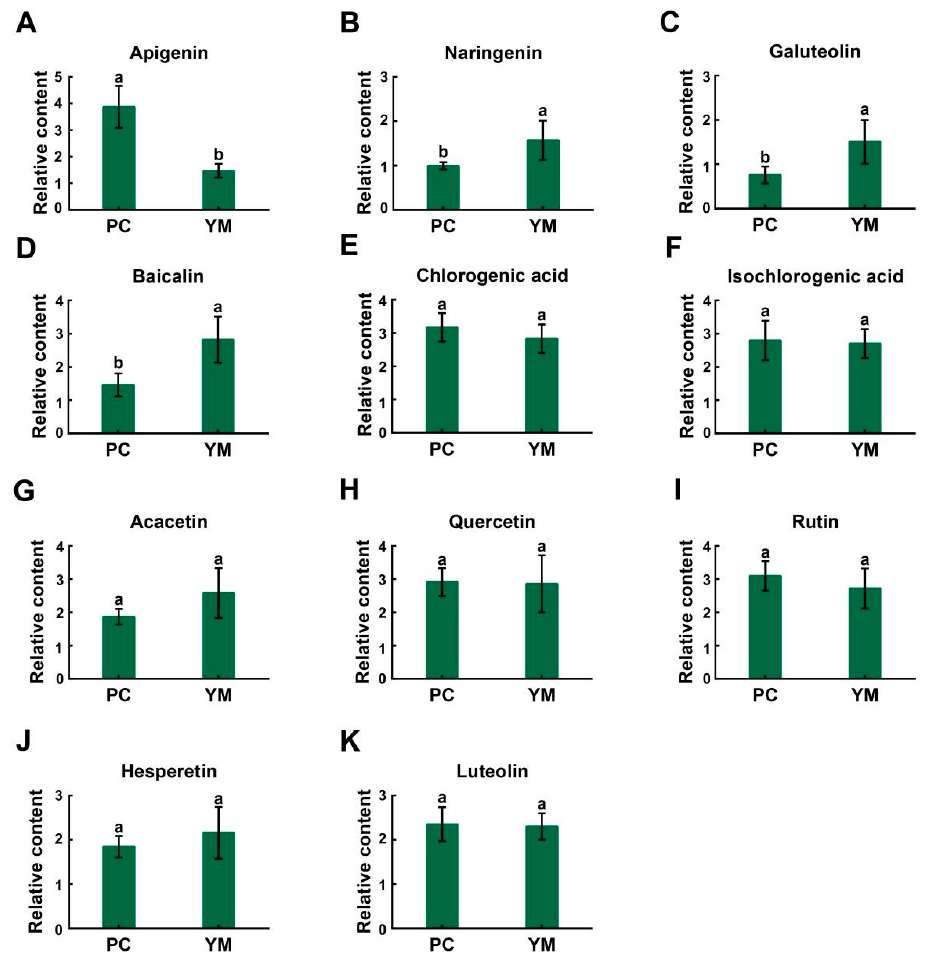
Figure 3. The analysis of secondary metabolites in the ray florets of PC and YM. The relative content of apigenin ( A ), naringenin ( B ), galuteolin ( C ), baicalin ( D ), chlorogenic acid ( E ), isochlorogenic acid ( F ), acacetin ( G ), quercetin ( H ), rutin ( I ), hesperetin ( J ), and luteolin ( K ) in ray florets of PC and YM. Different letters indicate significant differences at p < 0.05 according to Duncan’s multiple range test.